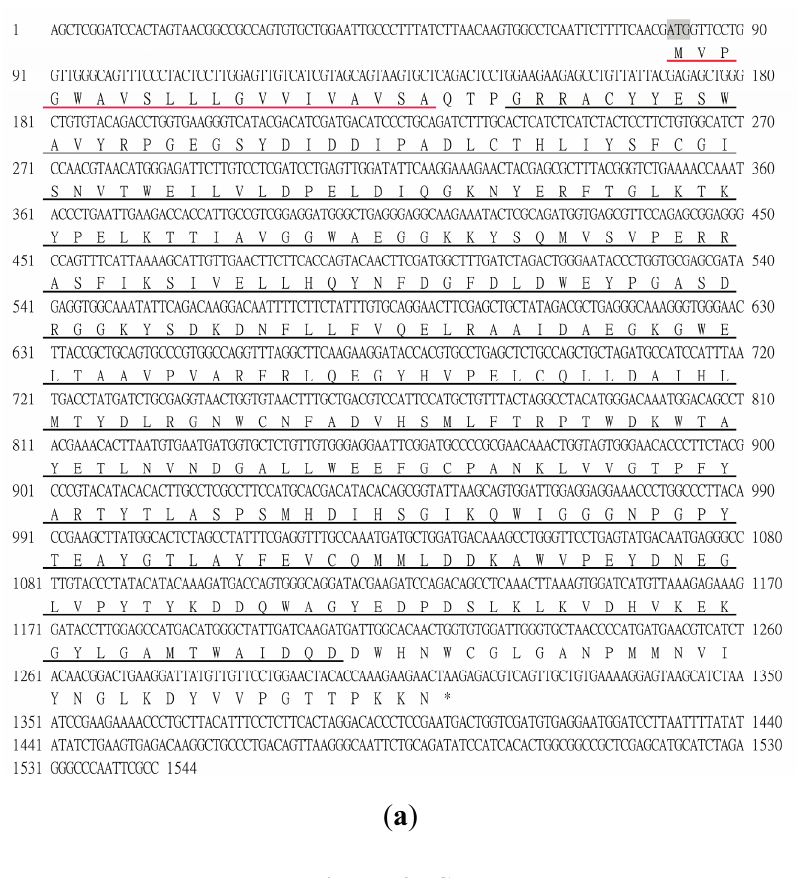
Figure 2. SDS-PAGE analysis of purified proteins. Lane 0, proteins before gel filtration; Lane 1–5, proteins collected after gel filtration, the order number was in accordance with gel filtration chromatogram (Lane 3, EcChi2; Lane 4, EcChi1); Lane M, Molecular weight